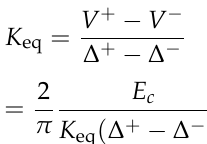
Table 4. Total dissipated energy of the test specimens.